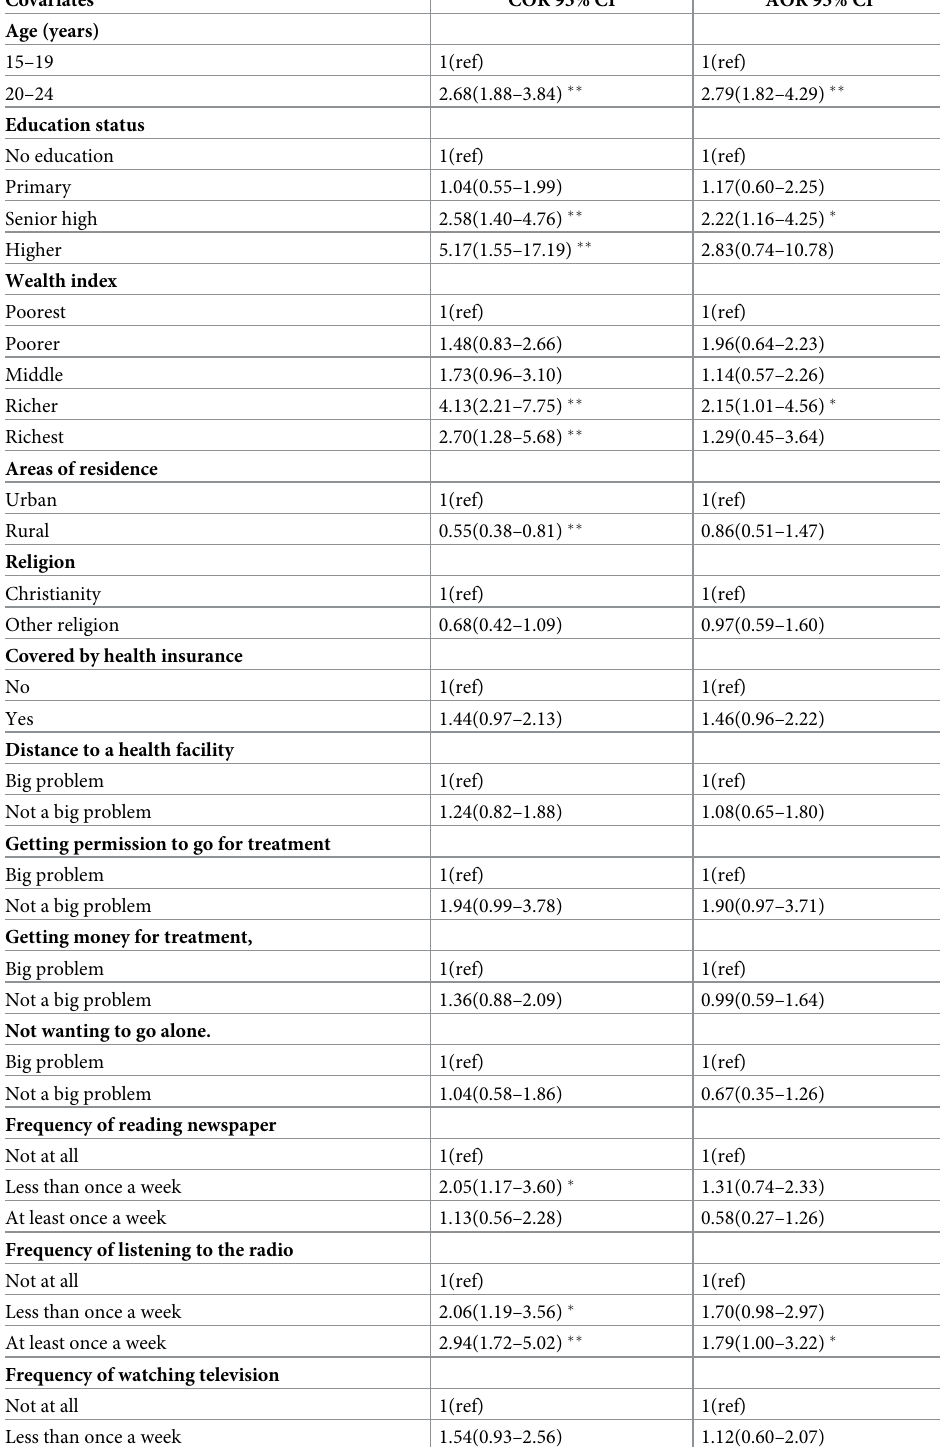
Table 4. Determinants of seeking treatment for STIs among young women in Ghana (n =